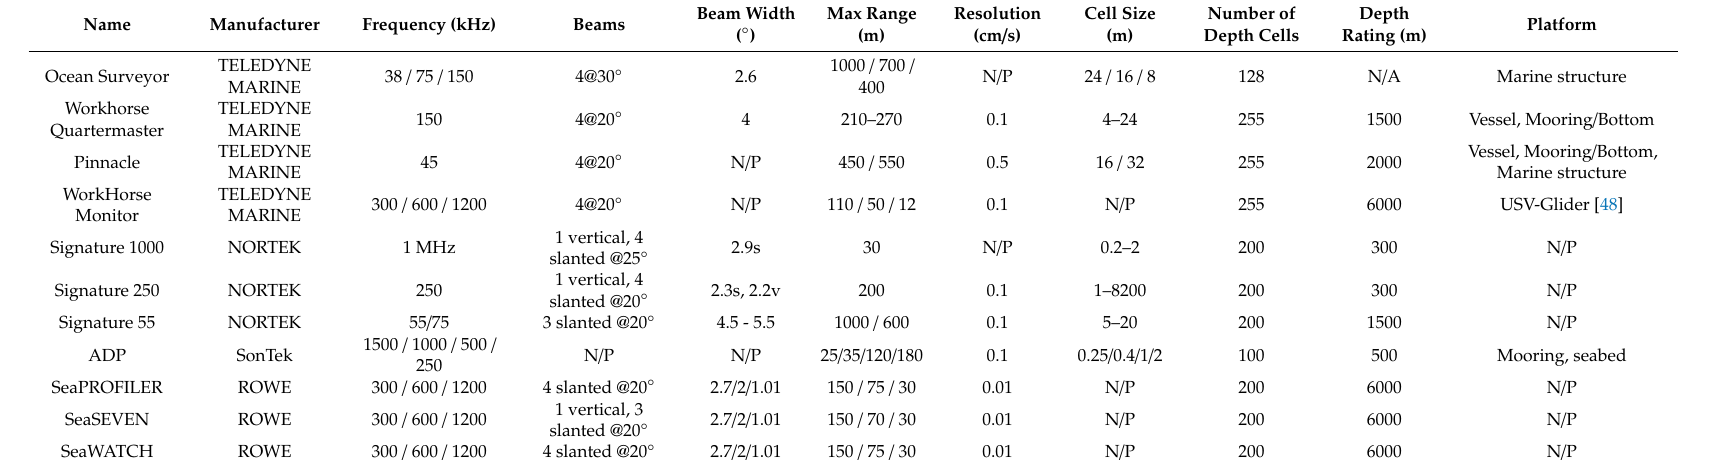
Table 17. Acoustic sensor: acoustic doppler current profiler (ADCP).